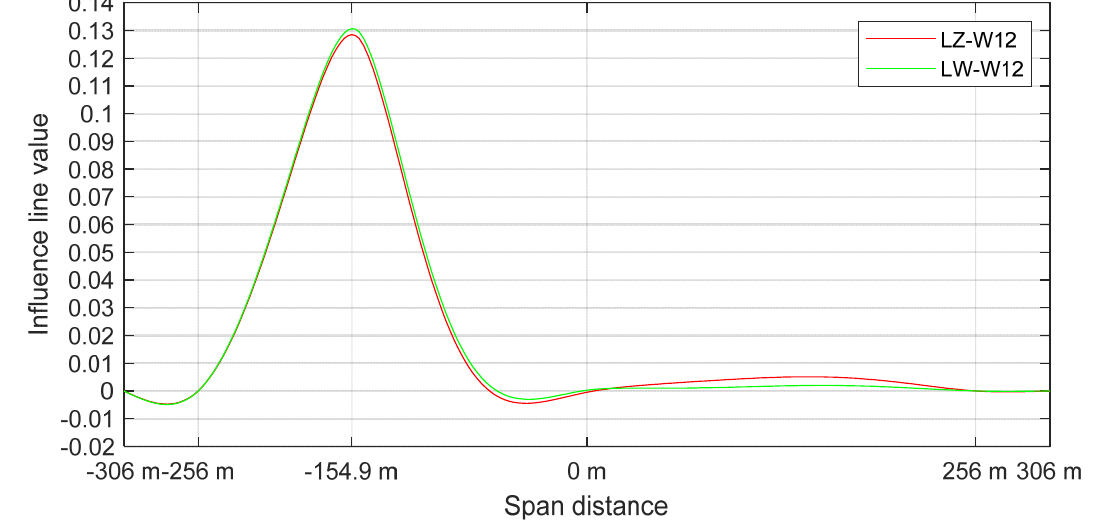
Figure 12. Influence line of tension force for cables LZ-W12 and LW-W12. Table 8. Selected and estimated force peaks in the year